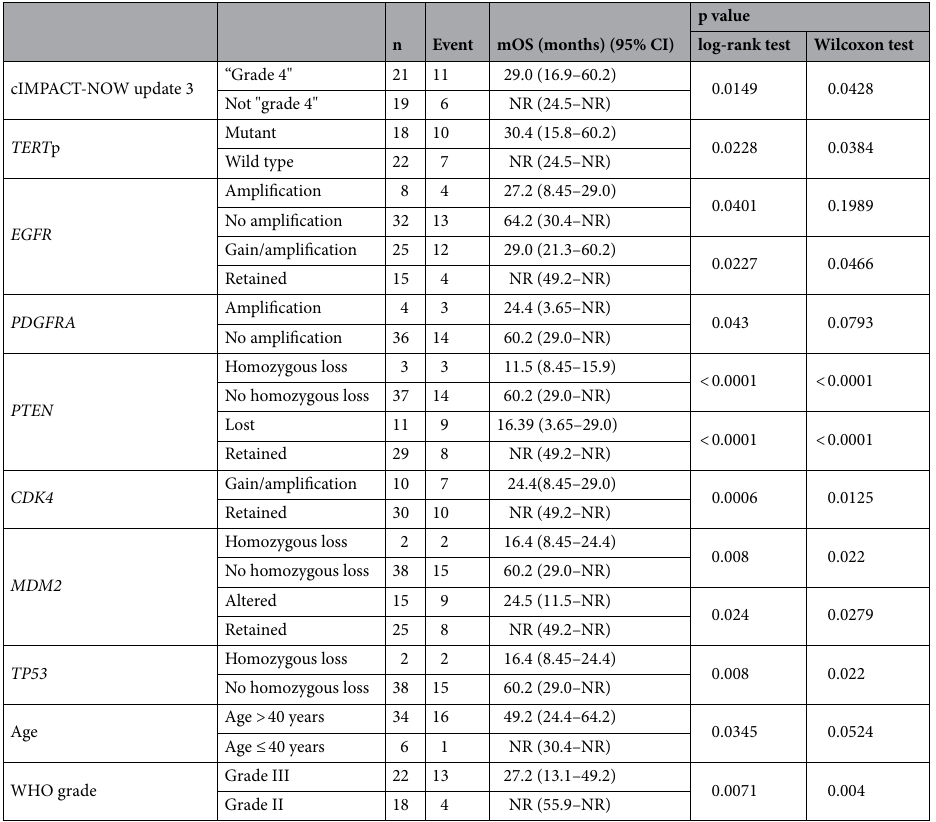
Table 2. Results of Kaplan–Meier analysis and survival analysis for factors showing significance in survival analysis. CI confidence interval, NR not reached, mOS median overall survival.